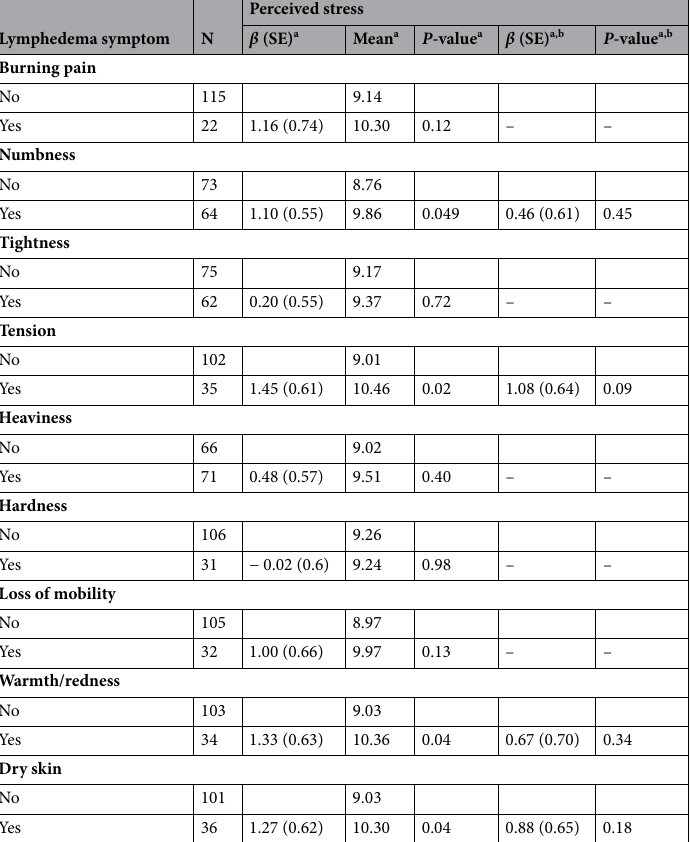
Table 2. Lymphedema symptoms and physical and mental component summary scores. MCS mental component summary, PCS physical component summary, SF‑36 36-item short form health survey, N number, SE standard error. a Standard analysis of covariance model adjusting for age at 40-month assessment and race/ ethnicity was used. b Mutually adjusted for numbness, tension, hardness, and warmth/redness, and additionally adjusted for change in clothing size/style due to lymphedema.